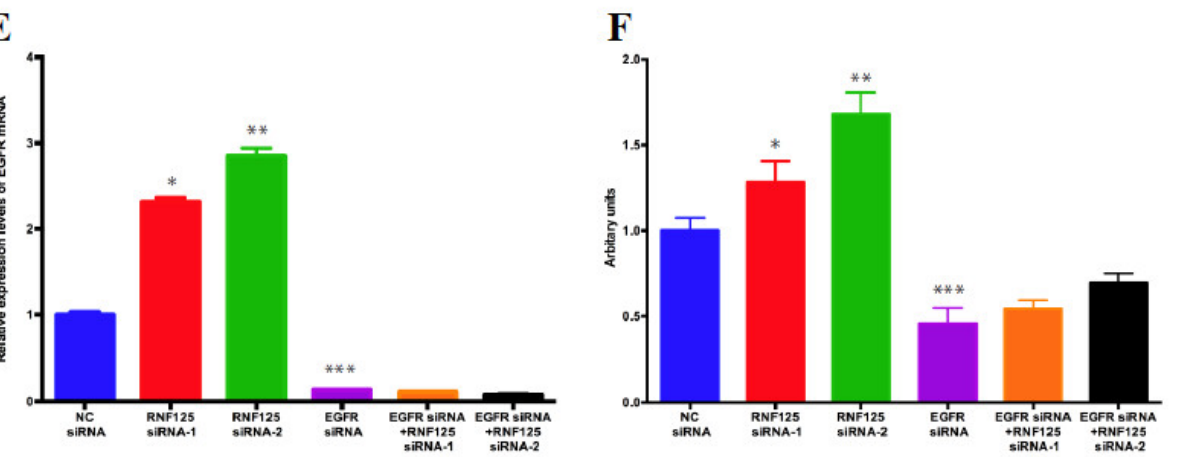
Figure 5. RNF125 suppresses cell proliferation through inhibiting the Egfr and Met pathway. ( A ) HepG2 cells were transfected with negative control (NC) siRNA or RNF125 siRNA. One day after transfection, 5 uM of tivantinib or DMSO was added to the well and incubated for 3 more days. Cell proliferation was assessed by WST-1 assay (N = 4, * p < 0.05 vs. NC siRNA and Tivantinib + RNF125 siRNA-1, ** p < 0.05 vs. NC siRNA and Tivantinib + RNF125 siRNA-2). ( B , C ) HepG2 cells were trans- fected with NC siRNA or RNF125 siRNA and/or Met siRNA. mRNA abundance of Met gene was assessed by qPCR 2 days after transfection (N = 4, * p < 0.05 vs. NC siRNA and MET siRNA + RNF125 siRNA-1, ** p < 0.05 vs. NC siRNA and MET siRNA + RNF125 siRNA-2, *** p < 0.05 vs. NC siRNA) ( B ). Cell proliferation was assessed by WST-1 assay 4 days after transfection (N = 4, * p < 0.05 vs. NC siRNA and MET siRNA + RNF125 siRNA-1, ** p < 0.05 vs. NC siRNA and MET siRNA + RNF125 siRNA-2) ( C ). ( D ) HepG2 cells were transfected with NC siRNA or RNF125 siRNA. One day after transfection, 10 uM of erlotinib or DMSO was added to the well and incubated for 3 more days. Cell proliferation was assessed by WST-1 assay (N = 4, * p < 0.05 vs. NC siRNA and Gefitinib + RNF125 siRNA-1, ** p < 0.05 vs. NC siRNA and Gefitinib + RNF125 siRNA-2, *** p < 0.05 vs. NC siRNA). ( E , F ) HepG2 cells were transfected with NC siRNA or RNF125 siRNA and/or EGFR siRNA. mRNA abundance of Egfr gene was assessed by qPCR 2 days after transfection (N = 4, * p < 0.05 vs. NC siRNA and EGFR siRNA + RNF125 siRNA-1, ** p < 0.05 vs. NC siRNA and EGFR siRNA + RNF125 siRNA-2, *** p < 0.05 vs. NC siRNA) ( E ). Cell proliferation was assessed by WST-1 assay 4 days